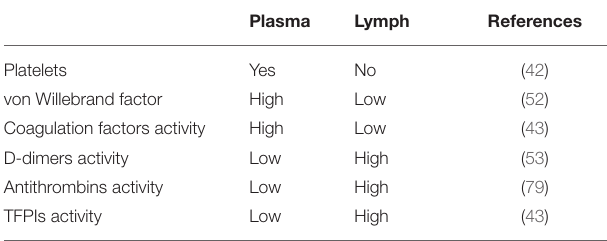
TABLE 1 | Hemostatic propertyin human plasma and